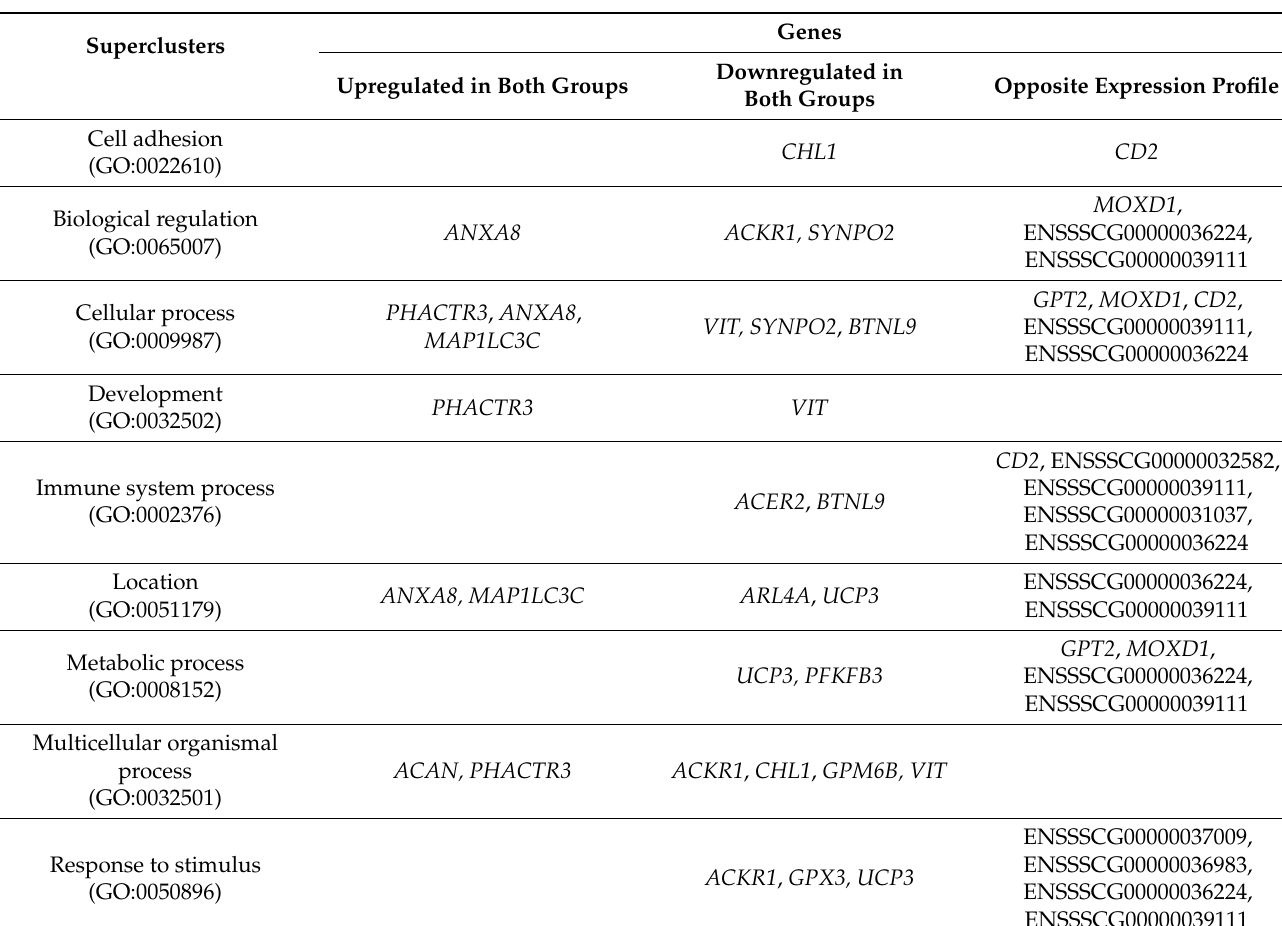
Table 4. Macro biological processes (superclusters) enriched with the 35 differentially expressed genes common to both types of